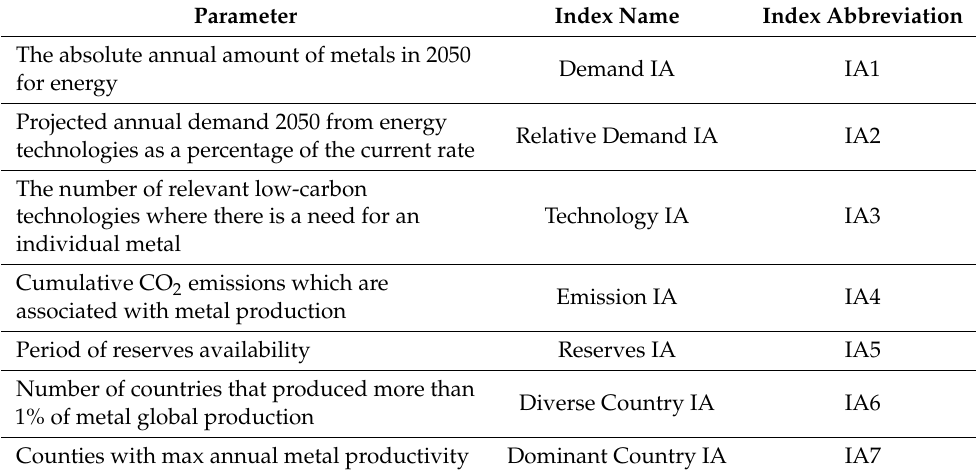
Table 1. Basic scoring